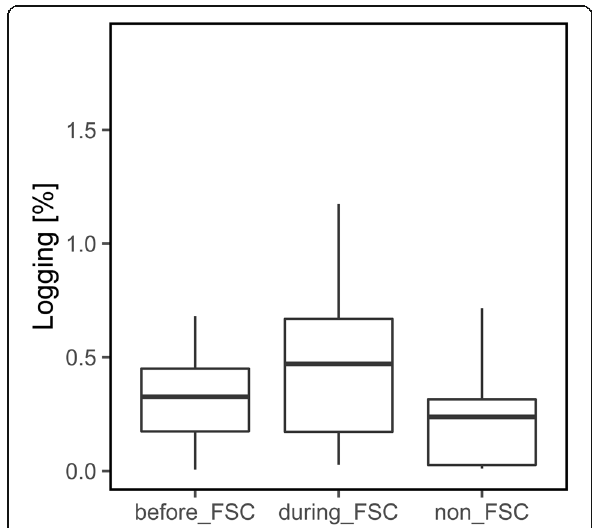
Fig. 2 Logging intensity in the sample area differentiating between areas that were under FSC-certification during the logging operation (during-FSC), areas that were harvested before they became certified (before-FSC), and areas that were never under certification (non- FSC): annual tree cover loss induced by logging in relation to the available area within the sampled study